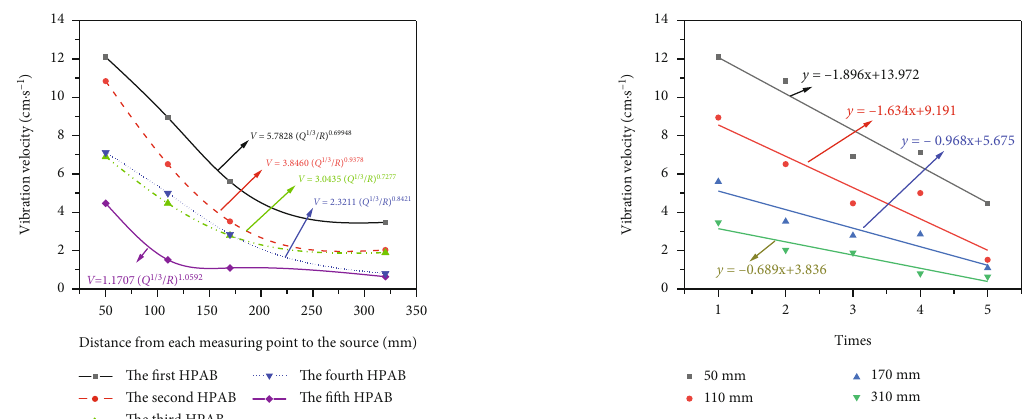
Figure 7: The curve of vibration velocity under multiple HPAB